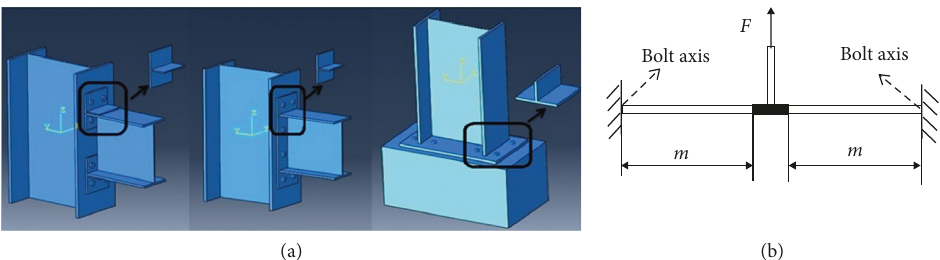
Figure 11: Mechanical model of the simplified equivalent T-stub. (a) The transformation of T-stub. (b) Simplified equivalent T-stub.